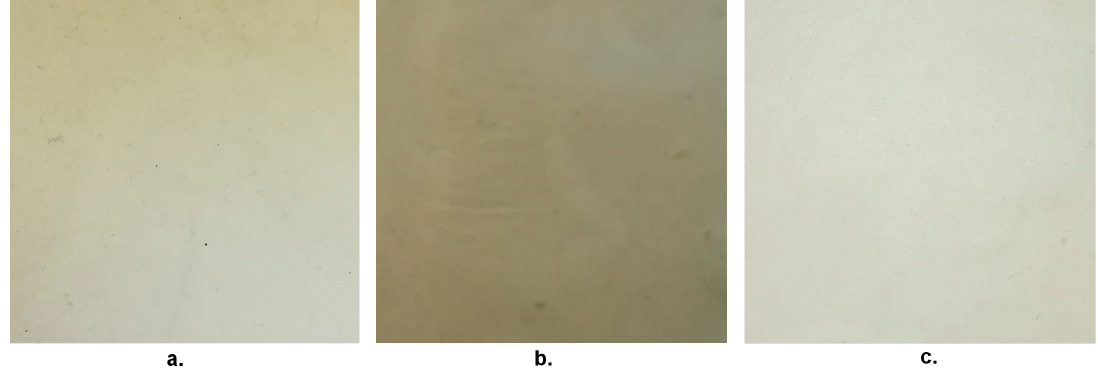
Figure 6. Surface appearance of the three TPS–mucilage films: Macerated (MA) (a.), Mechanically extracted (ME) (b.), Mechanically extracted post-maceration (MPM) (c.)